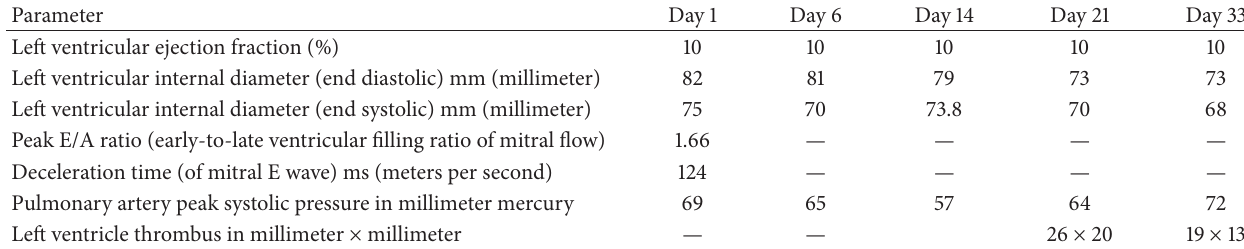
Table 2: Echocardiography measurements during hospitalization demonstrating left ventricle